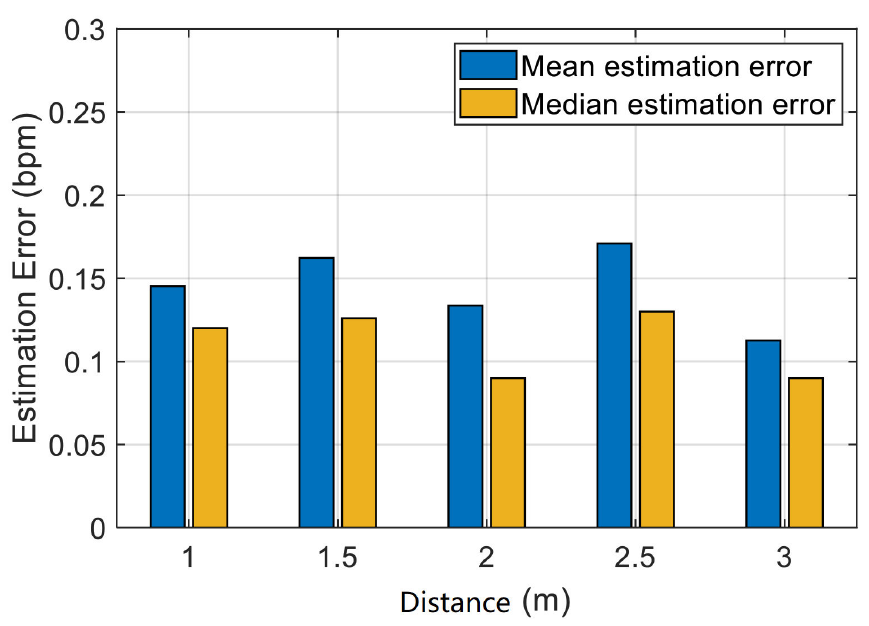
Figure 14. Impact of distance between the transmitter and the